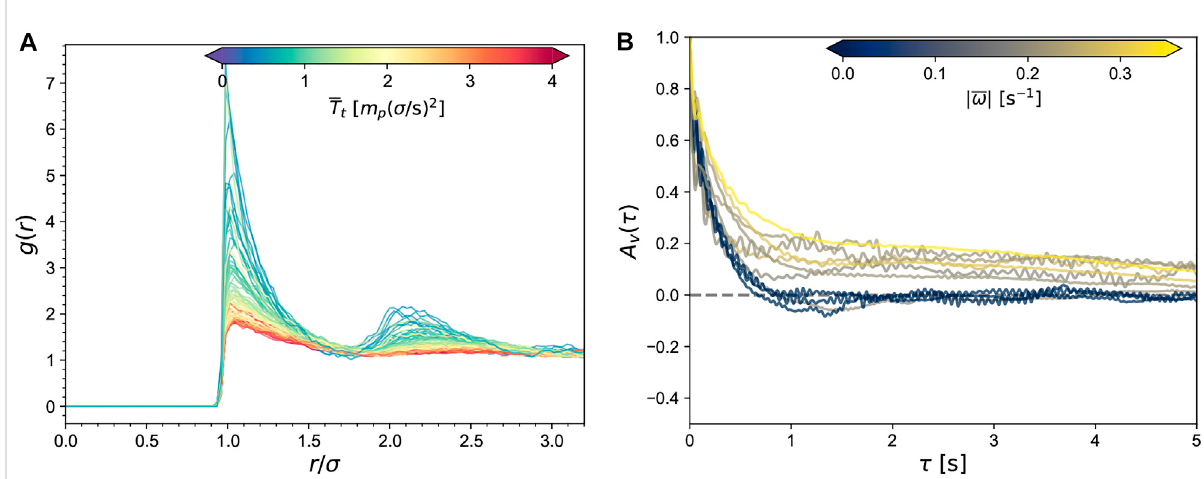
FIGURE 8 (A) Ensemble radial distribution function g ( r ) for all experiments. Color gradient indicates the energy input to the system. (B) Ensemble velocity autocorrelation function, as de fi ned in Eq. 1. The color gradient indicates the mean absolute value of the vorticity for that experiment, indicating a stronger chiral fl ow. We have plotted several cases with both spin-wise, counter-spin-wise, and no